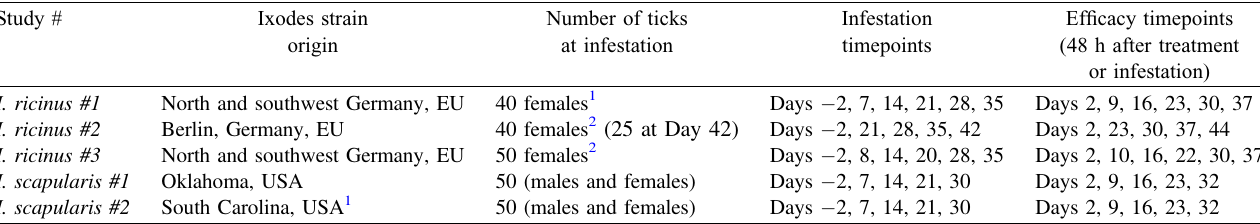
Table 2. Tick colonies (origin, number and sex), infestations and tick counts for ef fi cacy evaluations by study. Study #